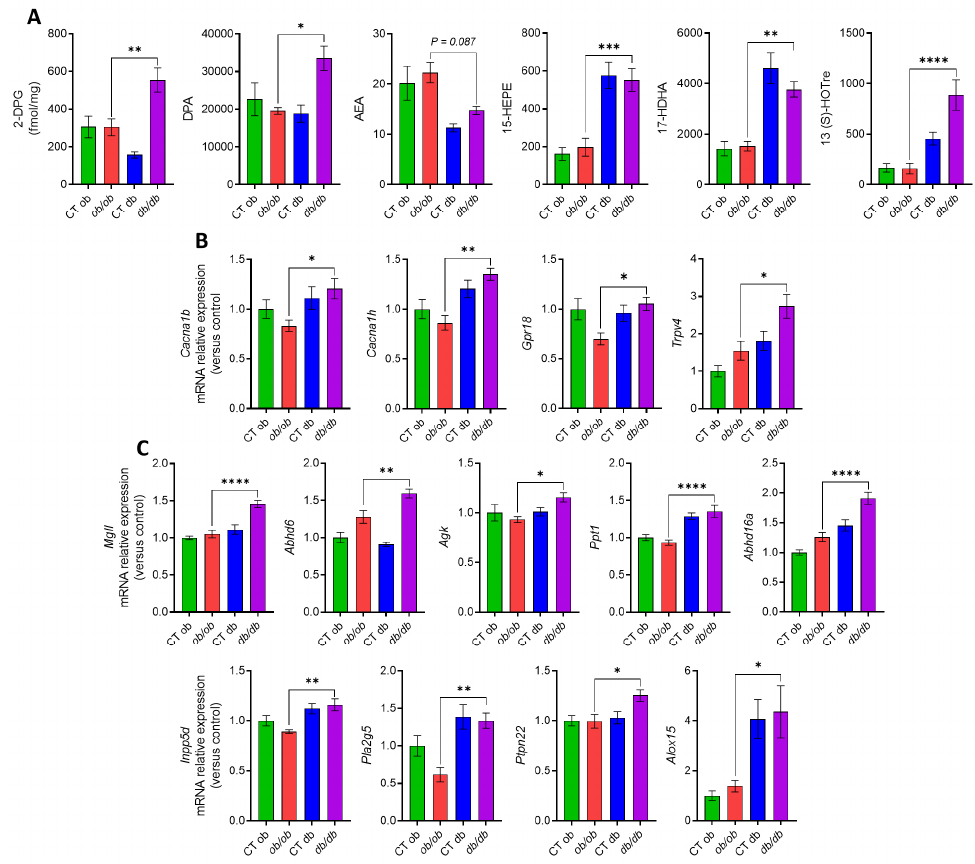
Figure 4. Different eCBome tone in the distal colon of ob/ob and db/db mice. ( A ) Concentrations of the eCBome ‐ related mediators in the colon (fmol/mg wet tissue weight) measured by HPLC ‐ MS/MS. ( B ) mRNA expression of receptors and ( C ) metabolic enzymes for 2 ‐ monoacylglycerols and N ‐ acylethanolamines measured by qPCR ‐ based TaqMan Open Array. Data are presented as the mean ± S.E.M of n = 7–10. * p ≤ 0.05, ** p ≤ 0.01, *** p ≤ 0.005, **** p ≤ 0.001. For mRNA expression, the relative units were calculated versus the mean of the CT ob mice values set at 1. Data were analyzed by one ‐ way ANOVA followed by Tukey’s post hoc test. Abbreviations: see Supplementary Tables S1 and S2.